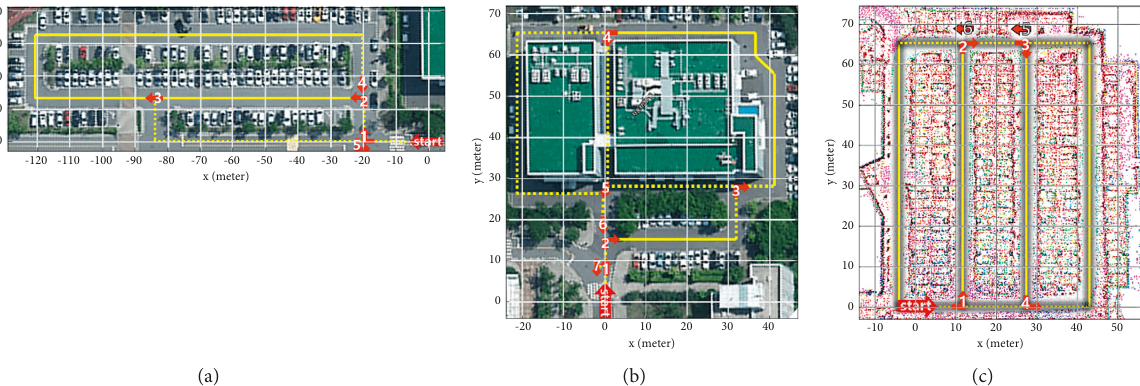
Figure 10: Parking lot environments for collecting perception data, (a, (b) outdoor parking lot and (c) indoor parking lot; the map image was built by LiDAR-based SLAM [34].